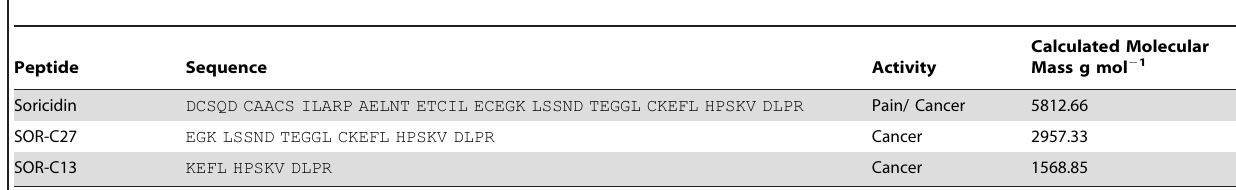
Table 1. Amino acid sequences of parent soricidin (accession number P0C2P6), SOR-C27 and SOR-C13.